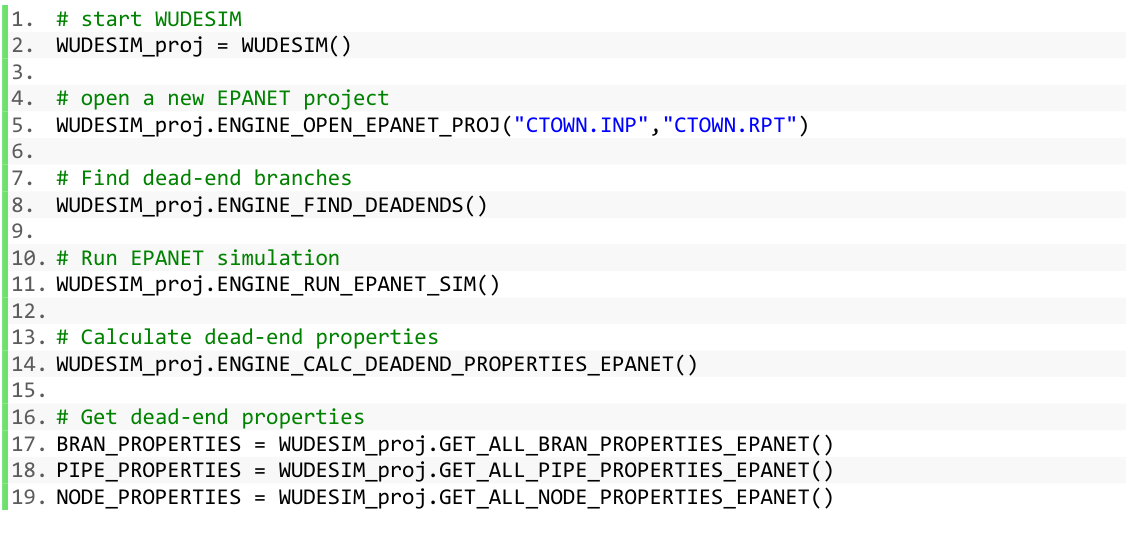
Figure 3. Example script for obtaining the properties of dead-end branches (DEBs) based on EPANET simulation .